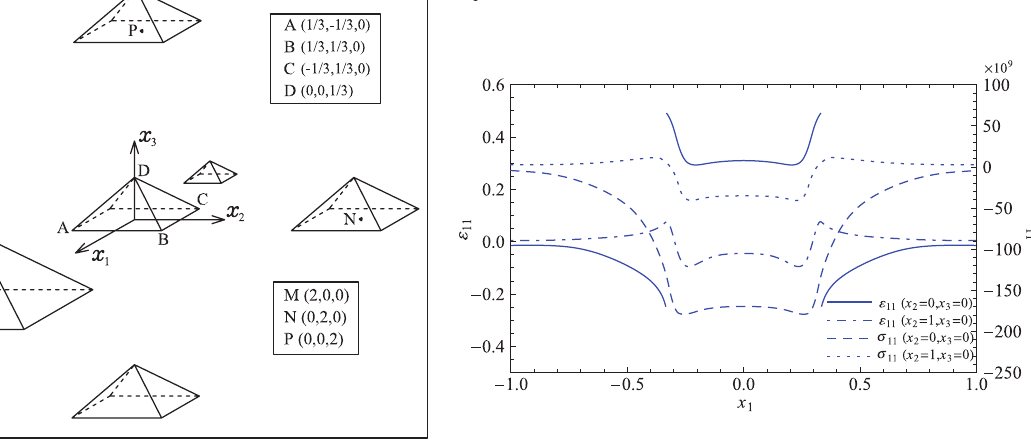
= 0 plane along x 3